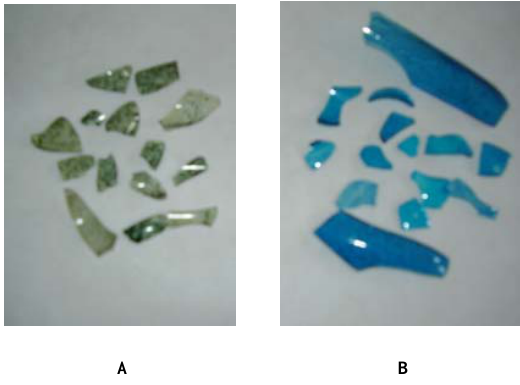
FIGURE 3 . Photograph of the conjugates obtained: (A) conjugate of ZnPcTS; (B) conjugate of